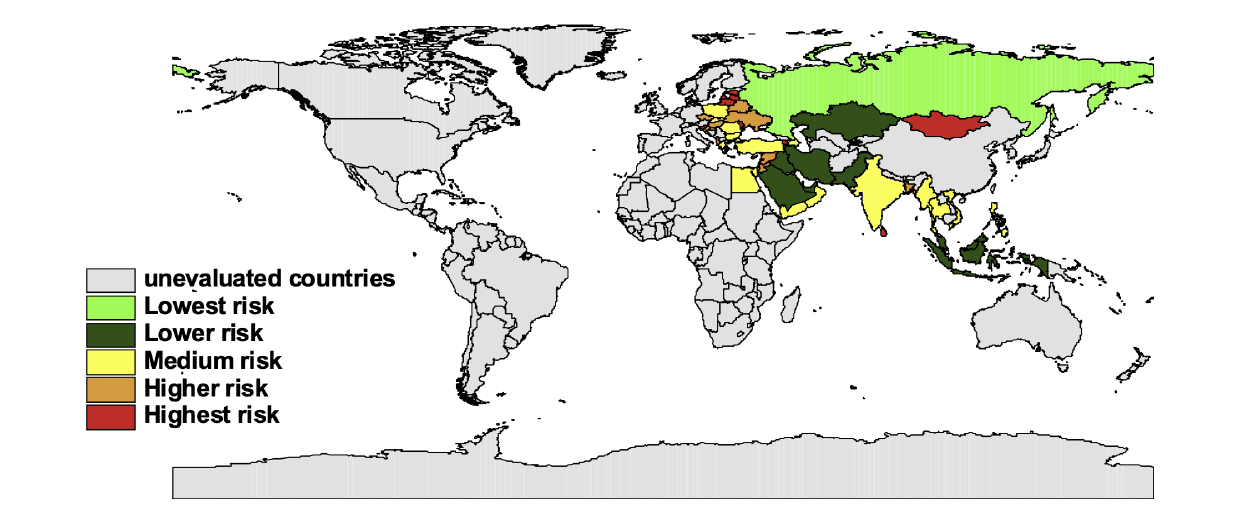
Figure 3. The results of the national energy investment risk